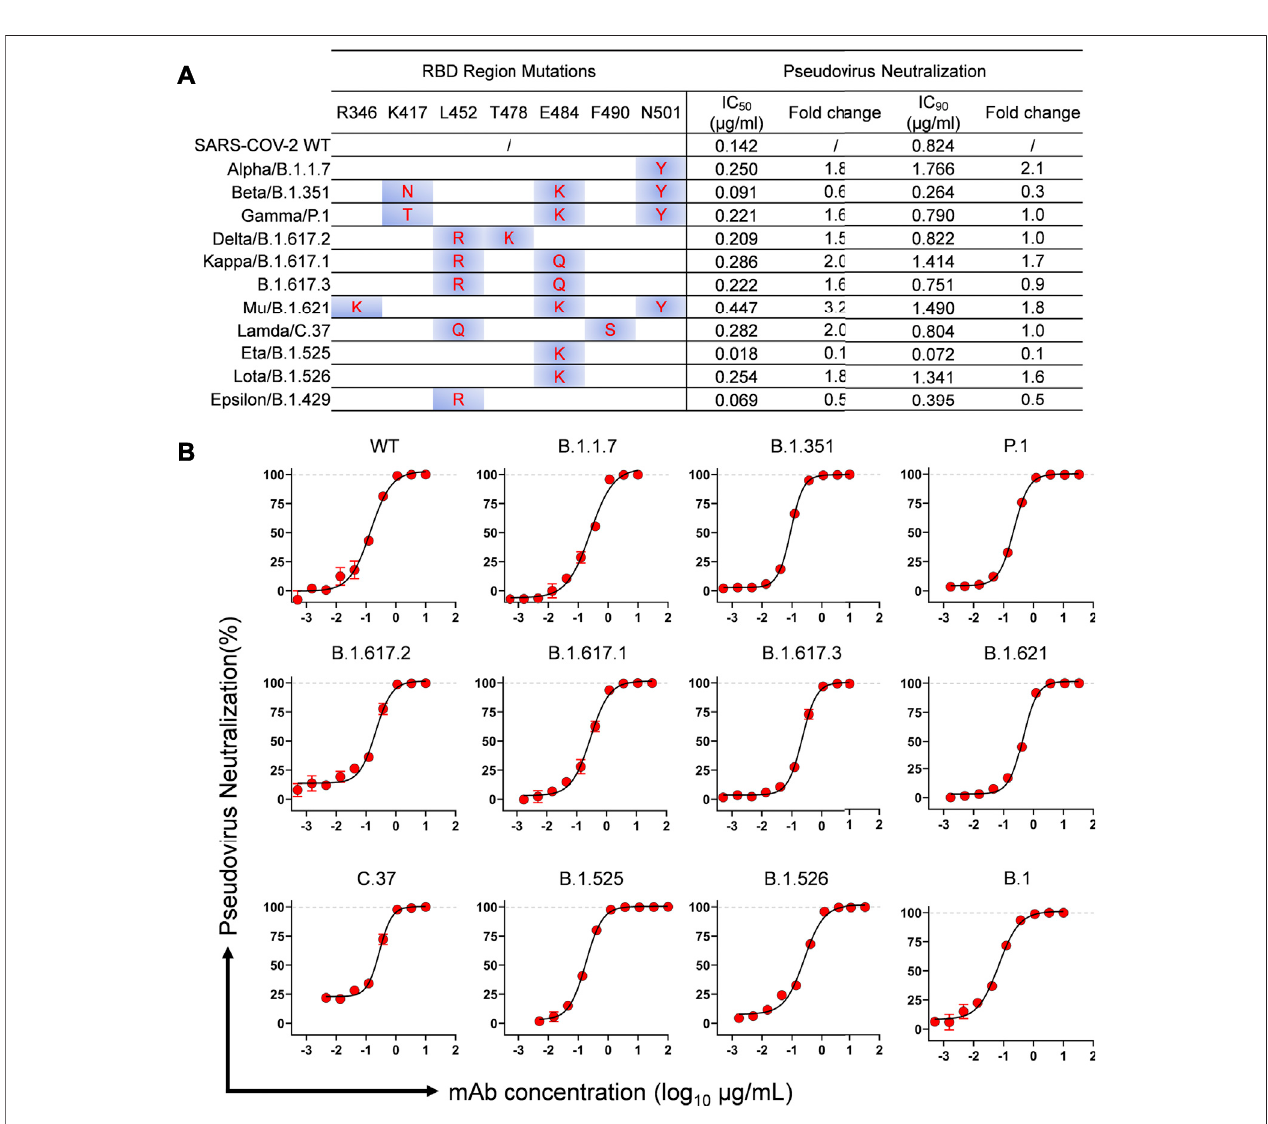
FIGURE1| NeutralizationactivityofMW3321againstSARS-CoV-2pseudovirusofdifferentvariantsonHuh7/ACE2cells. (A) Summaryofthemutationswithinthe RBDregionandneutralizationpotencyofMW3321.IC 50 andIC 90 areindicated.FoldchangewascalculatedbasedontheIC 50 orIC 90 valuesofMW3321toSARS-CoV- 2 wild-type virus and variants. (B) Neutralization curves of MW3321 to SARS-CoV-2 variants. The data points are represented as mean ± SD with n = 3.